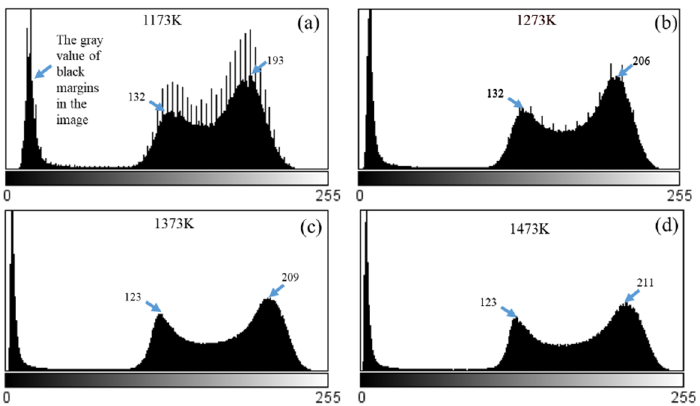
Figure 12. Distributions of grayscale values of different pictures in Figure 11 ( a ) 1173 K, ( b ) 1273 K, ( c ) 1373 K and ( d ) 1473 K. Table 2. Gray Values at Peak Sites in Figure 11 and Discrepancies Between the Bright and Dark Pixels.